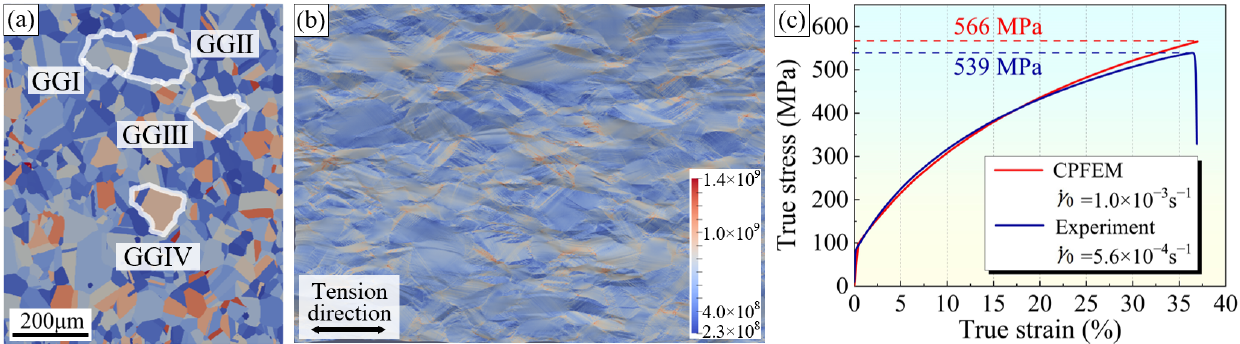
Figure 7. ( a ) The initial state of CPFE simulation and positions of grain groups. ( b ) The grain morphology and stress distribution in the simulated final state. ( c ) The true stress–strain curves acquired form the CPFE simulation and standard tensile